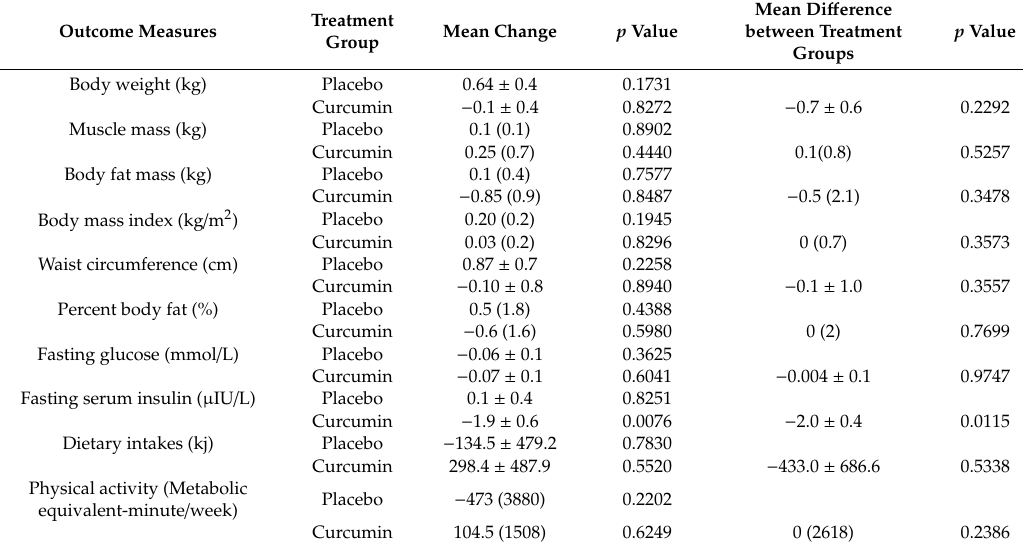
Table 2. Changes in the study parameters of the participants in placebo and curcumin group after three-month intervention